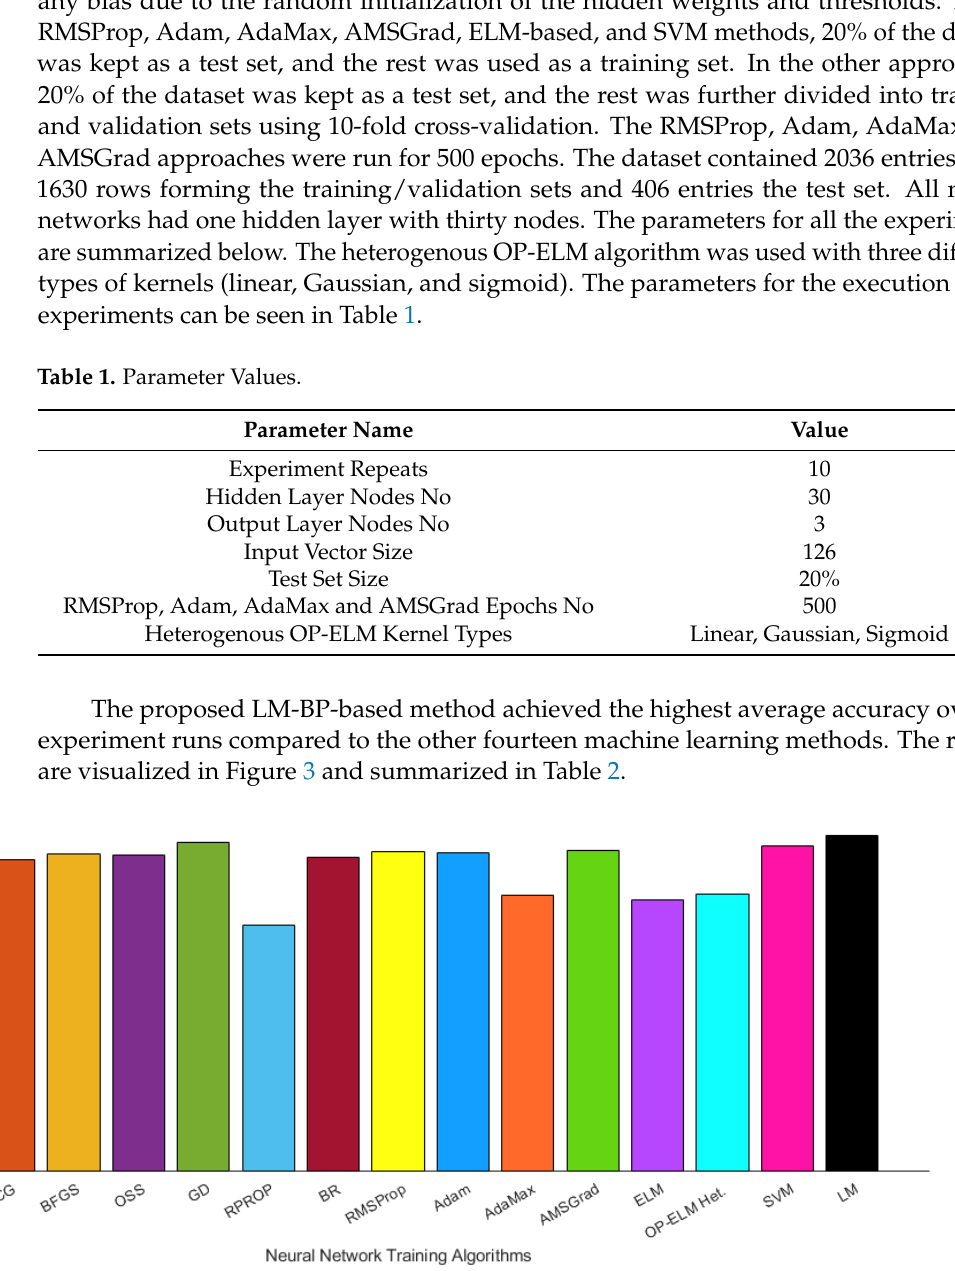
Figure 3. Experimental results plot. The proposed LM-BP-based system achieved the highest accuracy compared to fourteen existing machine learning algorithms.